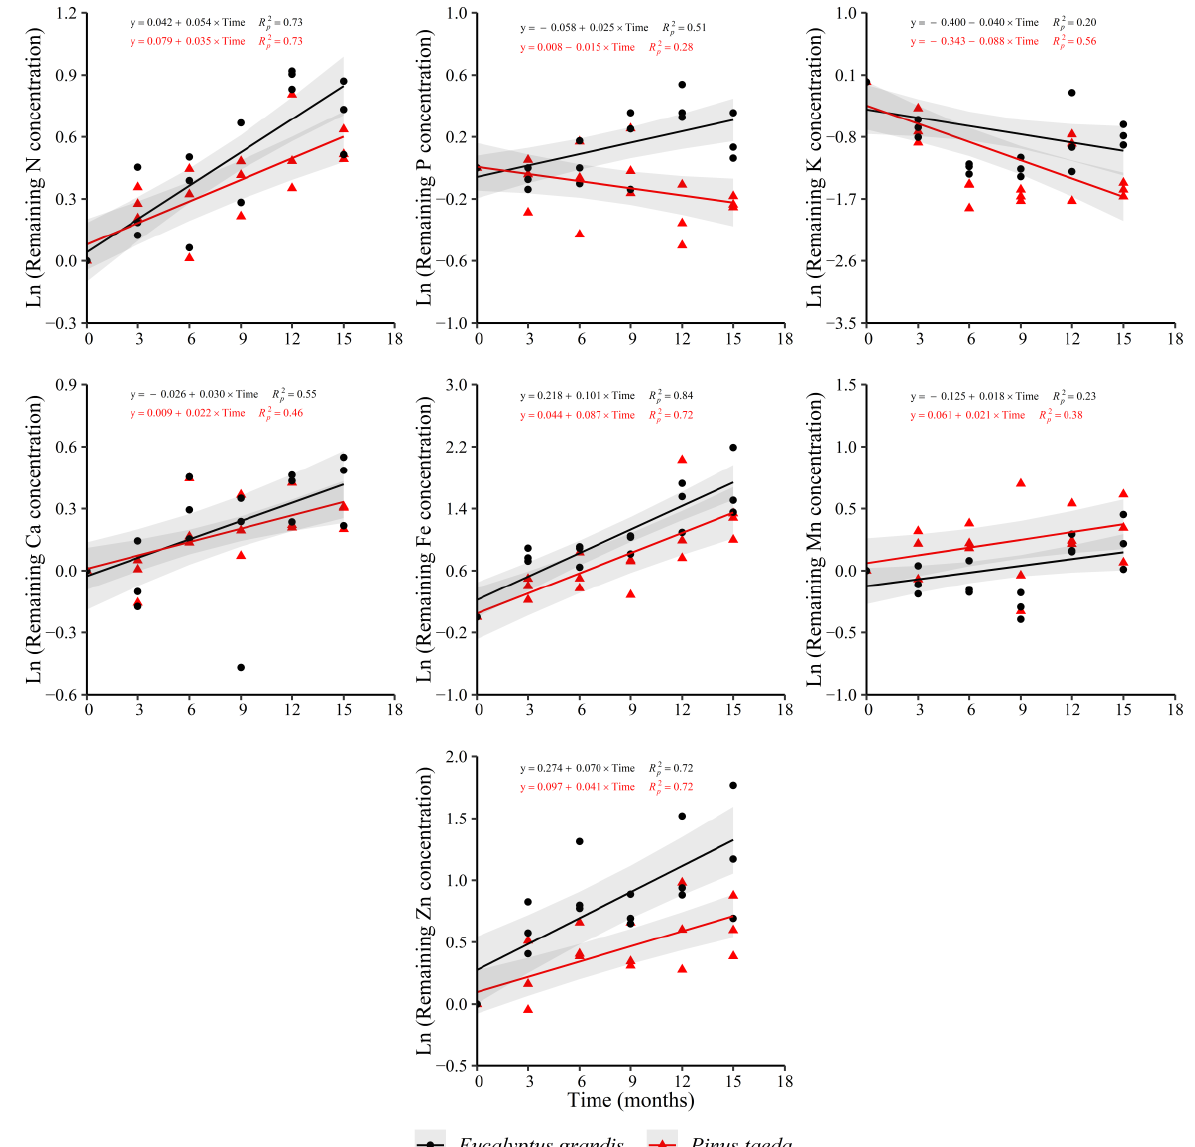
Figure 4. Remaining nutrient concentration of E. grandis (black symbols) and P. taeda (red symbols) litter for the different sampling moments (C3 layer). The gray bands around the models represent the 95% confidence interval.